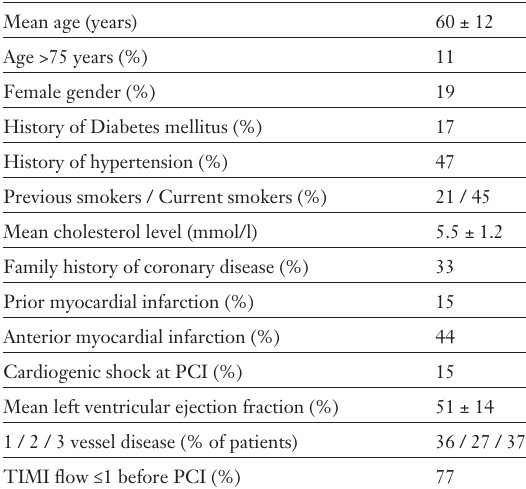
Patient character-